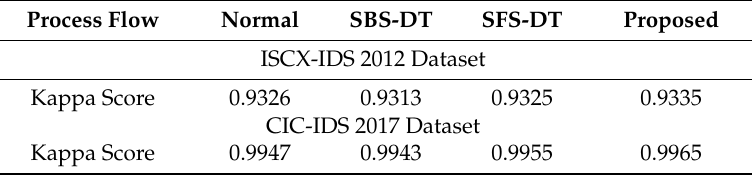
Table 10. Cohan’s kappa coe ffi cient score based on test